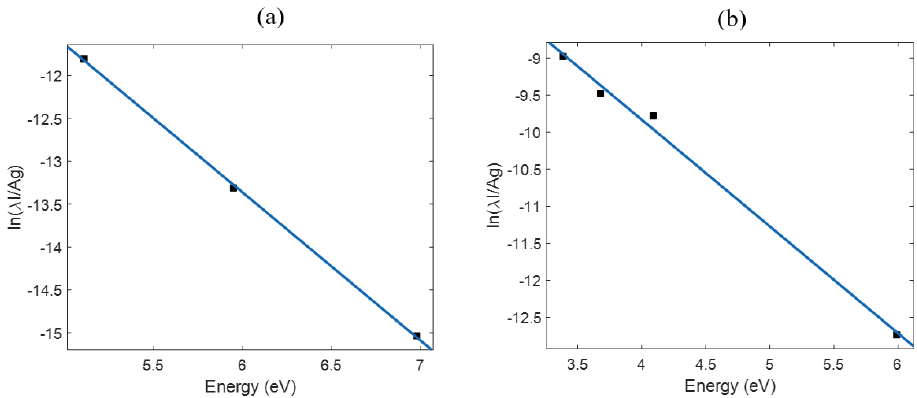
Figure 8. ( a ) The Boltzmann plot obtained from the Mg lines with a laser fluence of 12.9 J cm − 2 without sample heating. ( b ) the Saha–Boltzmann plot of the Ti lines with a laser fluence of 12.9 J cm − 2 without sample heating.